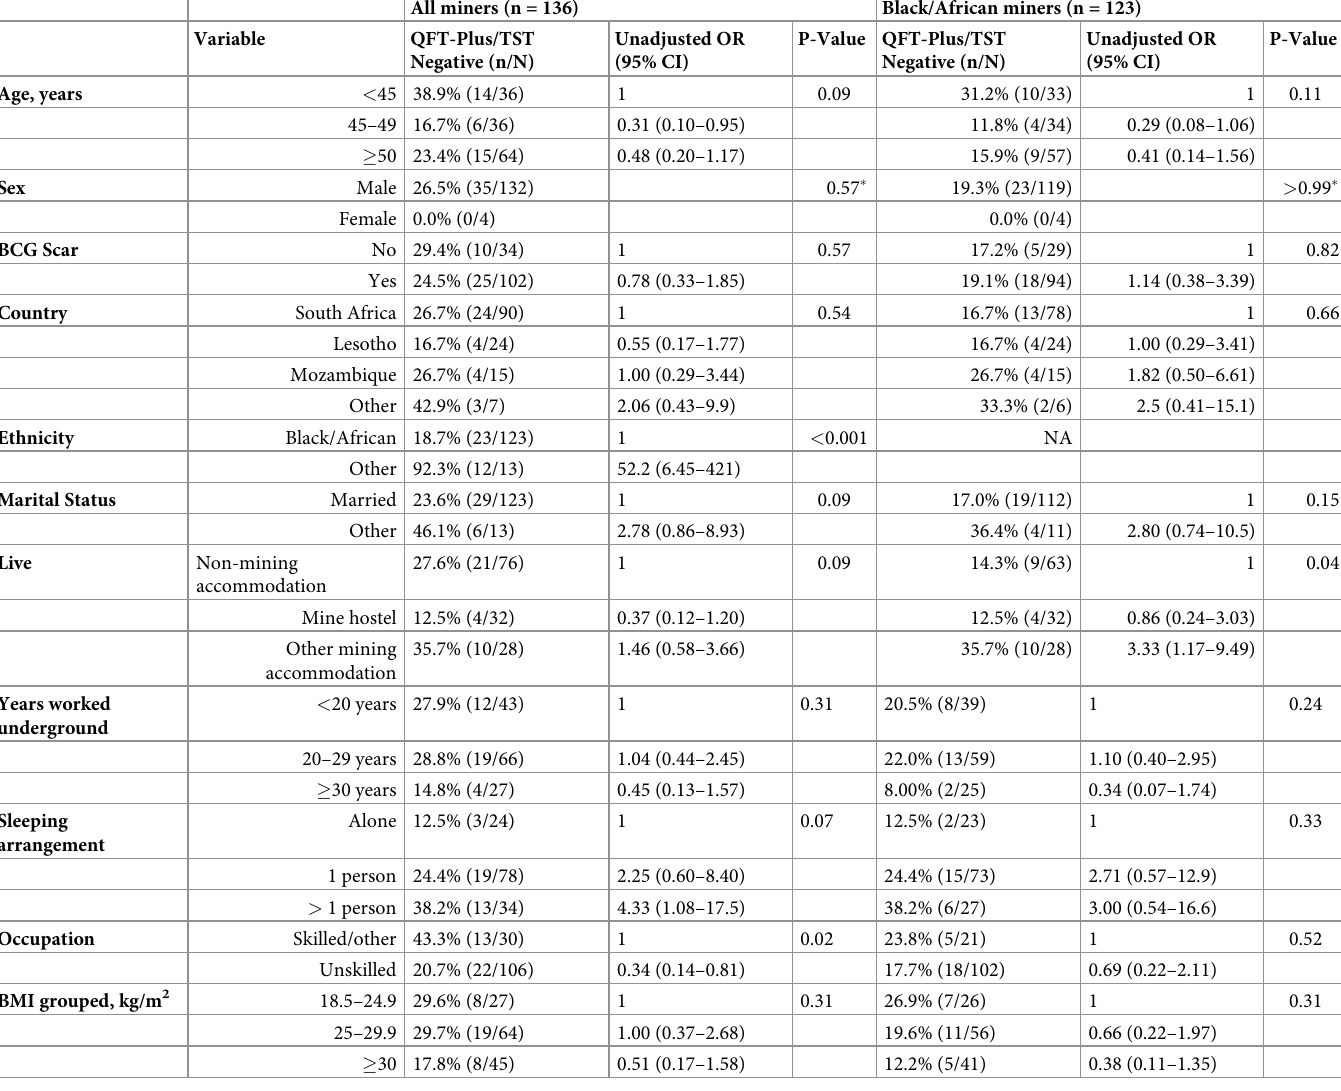
Table 3. Factors associated with being TB uninfected defined as being QuantiFERON-TB Gold-Plus negative and tuberculin skin test zero mm response† among miners attending for annual medical examination (n = 136) and restricted to Black/African miners (n =